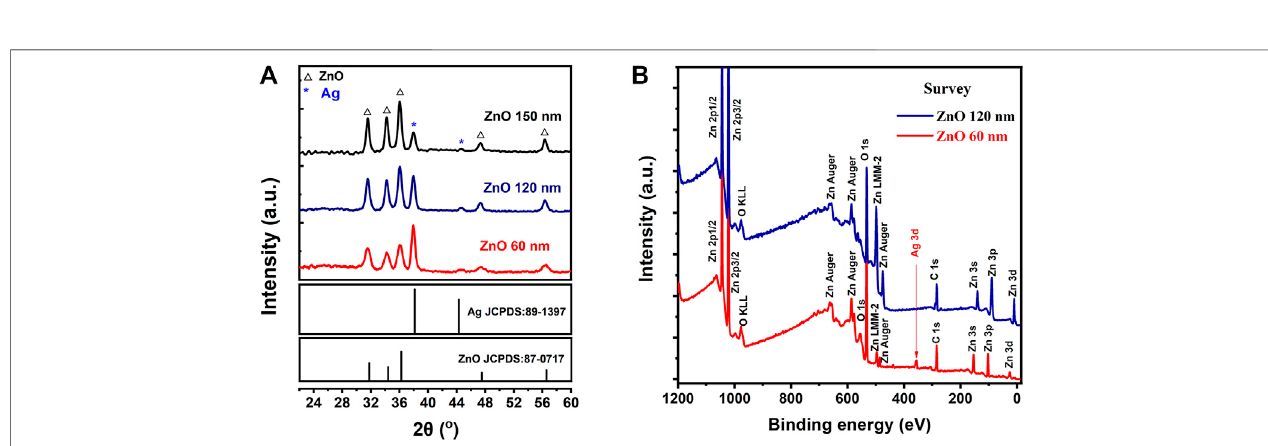
FIGURE4| CompositionandstructuralanalysisofAgNWs/ZnO fi lms. (A) XRDpatternsand (B) XPSsurveyspectraofAgNWs/ZnO fi lmswith60 nm-and120 nm- thick ZnO.